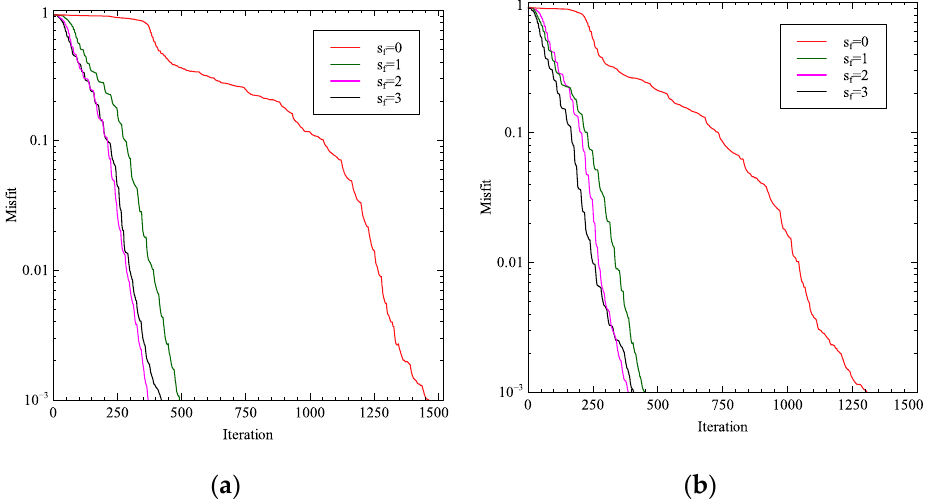
Figure 5. The iterative process corresponding to each 𝑠 (cid:3033) . ( a ) the fitting process for the rectangular prism, ( b ) the fitting process for the dipping prism.